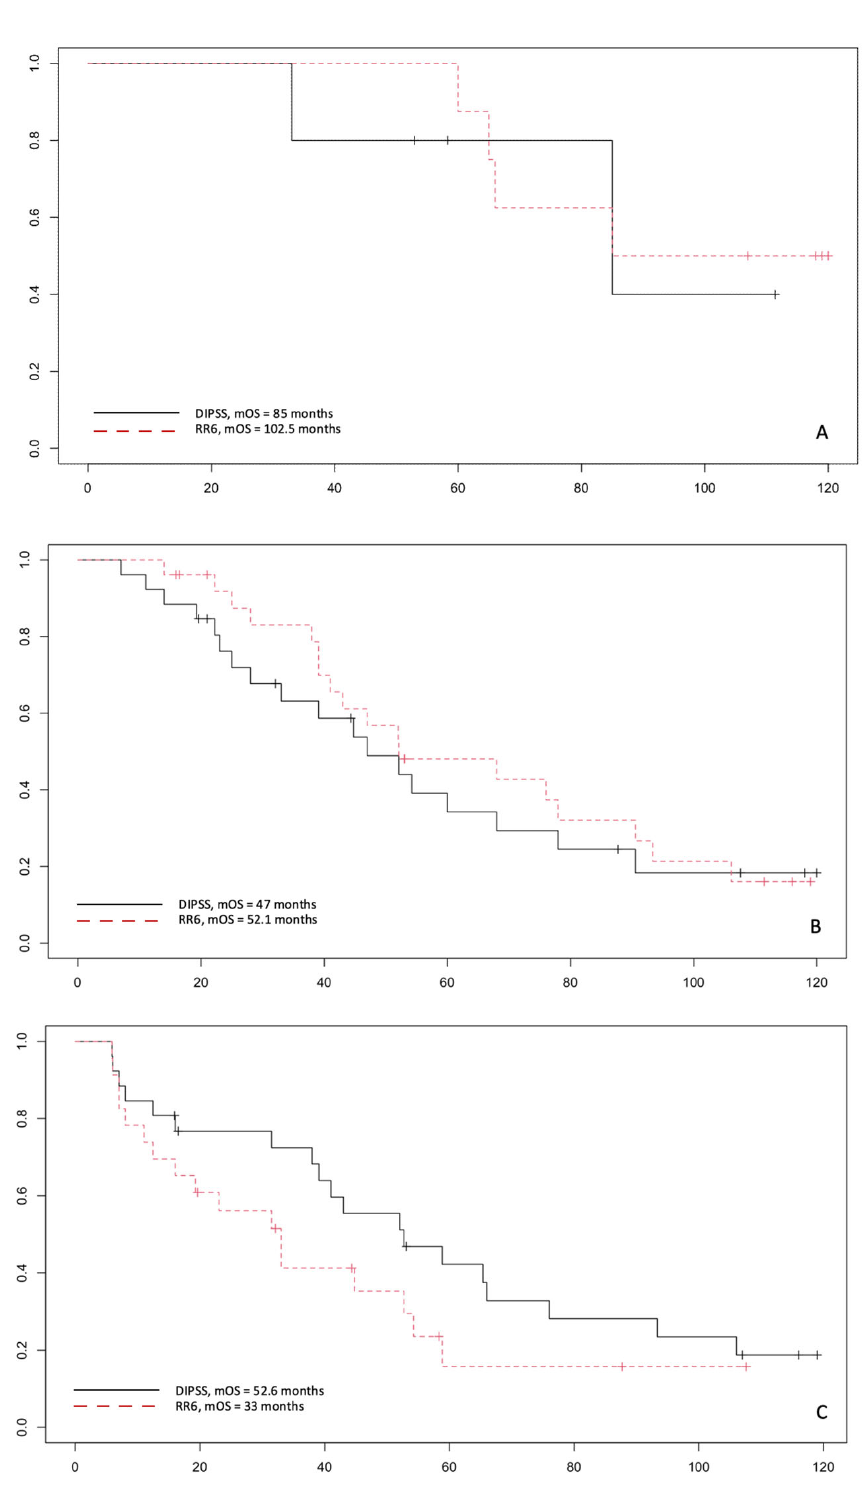
Figure 4. Survival curves in patients with primary myelofibrosis in risk RR6 low with DIPSS low ( A ); RR6 intermediate with DIPSS Int-1 ( B ); RR6 high with DIPSS Int-2 and high classes ( C ). NR: not reached.